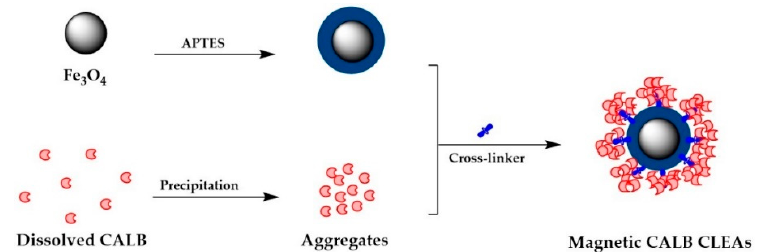
Figure 1. Schematic illustration of the immobilization process to produce magnetic CALB CLEAs. APTES is 3-aminopropyltriethoxysilane, CALB is lipase B from Candida antarctica , and CLEAs is cross-linked enzyme aggregates.